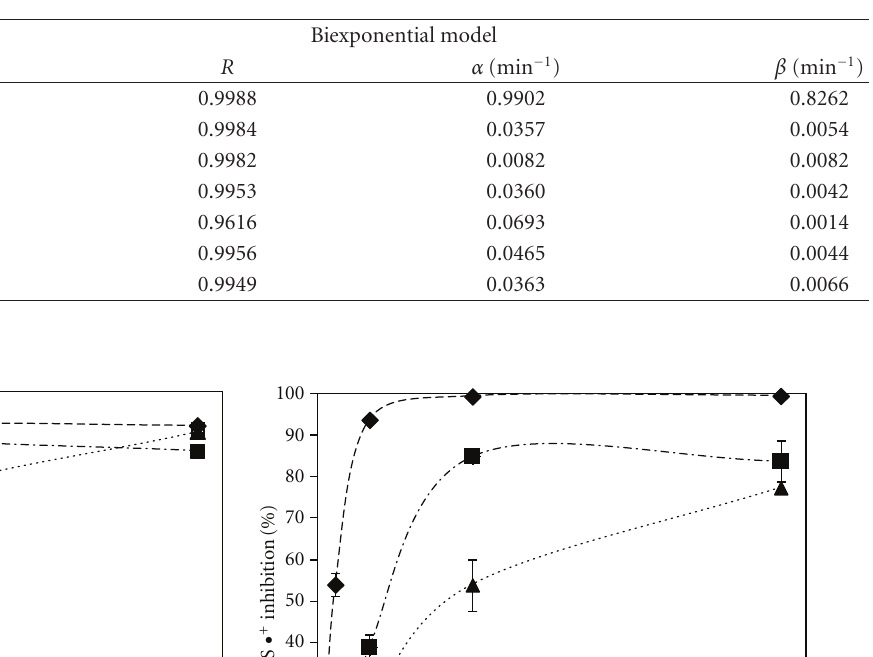
Table 4: Release data obtained by fitting the dissolution profiles of pure resveratrol and PHBV/PCL microparticles to the biexponential equa- tion.